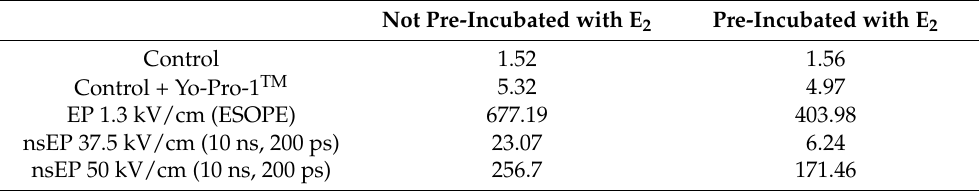
Table 3. Yo-Pro-1 TM fluorescence intensity in MDAH-2774 cells in arbitrary units;